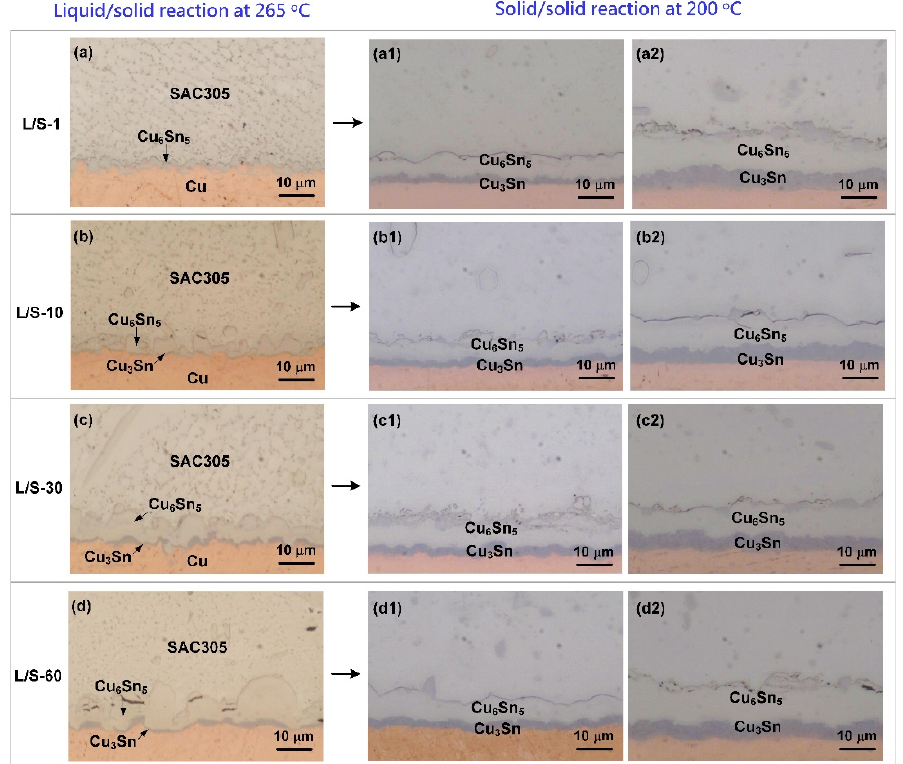
Figure 2. Cross-sectional OM micrographs of the cross-sections of the SAC305/Cu joints after the liquid/solid and solid/solid reactions. ( a ) 1 min; ( b ) 10 min; ( c ) 30 min; ( d ) 60 min; ( a1–d1 ) 72 h; ( a2–d2 ) 360 h.